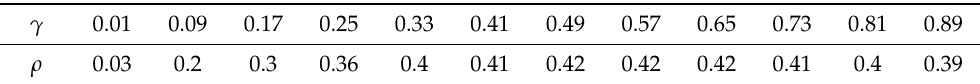
Table 4. Values of the rho of Spearman of the GCC copula for θ = ( γ ,1/ γ ,1/ γ ) and several values of γ , belonging to Configuration 1.